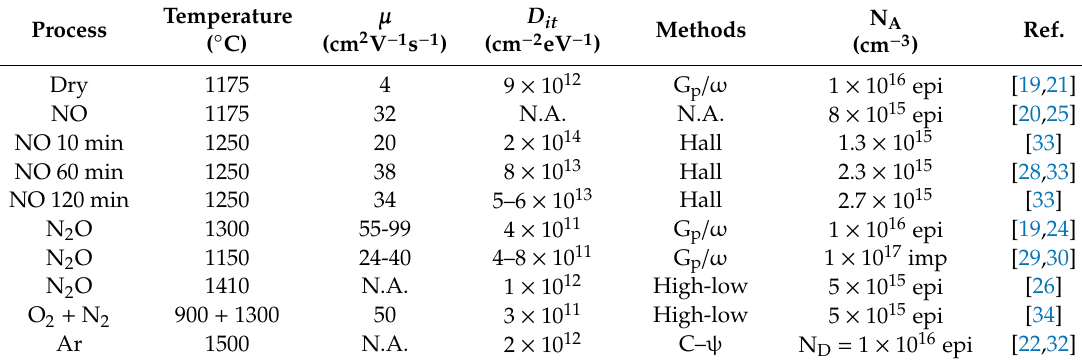
Table 1. Summary of field e ff ect mobility µ FE and interface states density D it data in 4H-SiC MOSFETs and MOS capacitors. The processing conditions of the gate oxide (on epitaxial or implanted body), the extraction method of D it , and the doping N A of the p-type body concentration are also